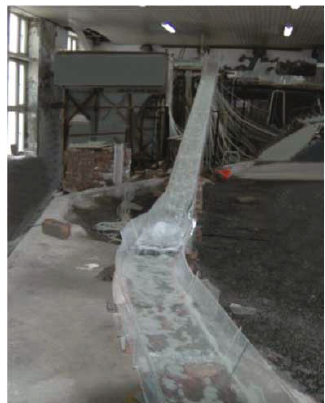
Figure 3: The full view of model in the